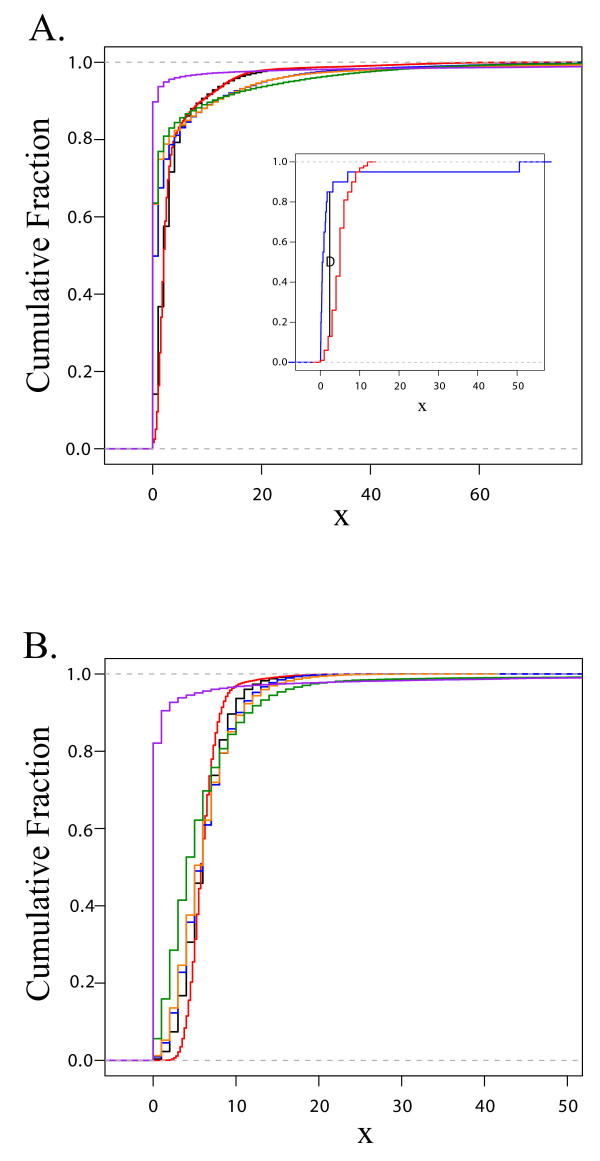
A & B: Empirical cumulative distribution functions. A. Empirical cumulative distribution function (ECDF) depicting the distributions of counts per bin for various control and amplified populations of Halobacterium species NRC-1 DNA. The ECDF represents the cumulative distribution of the number of counts per bin, reporting the cumulative proportion of bins with counts equal or less than the value on the X axis. The control cumulative fraction (black) is plotted against all WGA approaches; GenomiPhi in blue, Repli-G in orange, PEP in green and DOP in purple. Inset. Generic ECDF of two different distributions (red and blue), the D statistic is shown as black vertical line labelled "D". B as Figure 4A, but derived from Campylobacter jejuni.